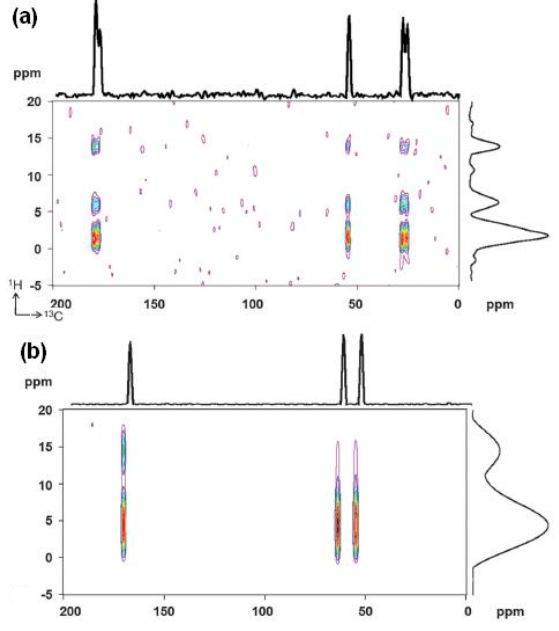
Figure 11. 13 C{ 1 H} HETCOR 2D spectrum of ( a ) 200 mM Glu and ( b ) 200 mM Ser-OPO 3 . From Ref. [45] with copyright (2015) permission from the Royal Society of Chemistry.